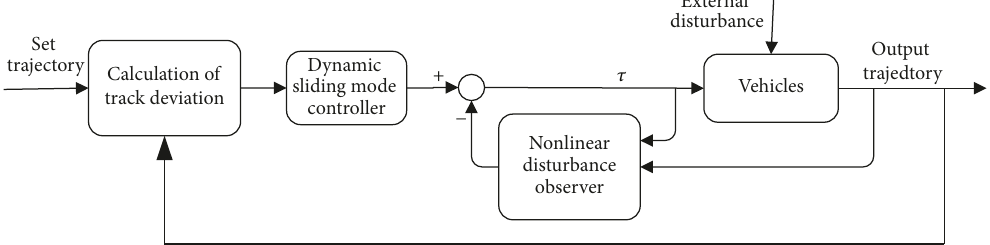
Figure 1: Schematic of the control system for UMV.